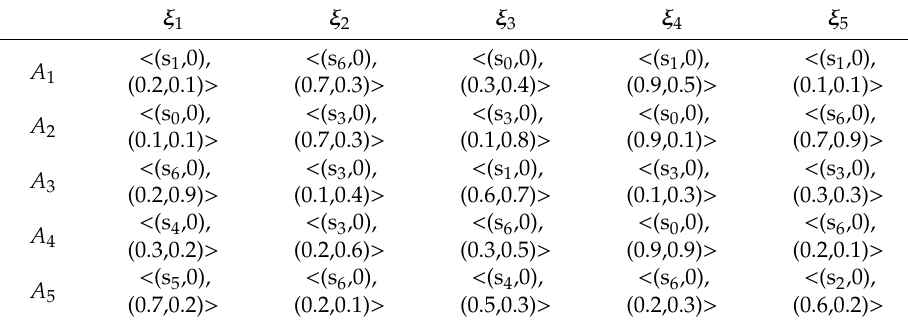
Table 4. P2TLN decision matrix by DM 4 .